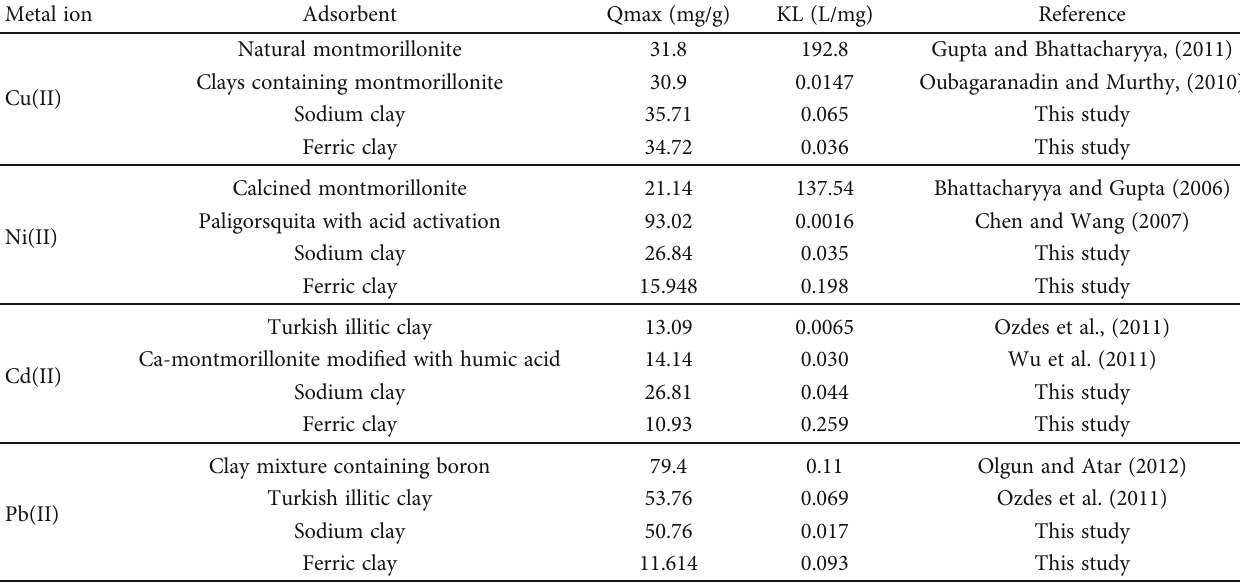
Table 3: Comparison of Langmuir parameters on the adsorption of the ions Cu(II), Ni(II), Cd(II), and Pb(II) in these work clays and the literature.